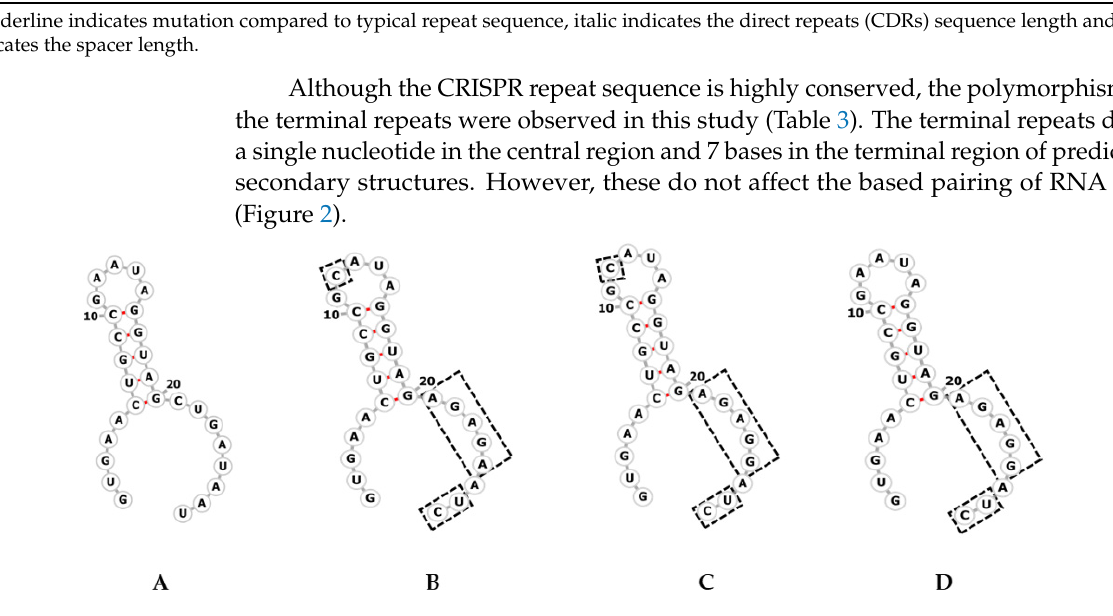
Figure 2. The secondary structures of four CRISPR repeats found in V. parahaemolyticus isolates. Predicted secondary structures were obtained using RNA fold. The dashed boxes indicate the sequence differences between typical repeat ( A ), and terminal repeat of tdh + trh − ( B ), tdh+ trh + and tdh + trh − ( C ), and tdh − trh − ( D ) V. parahaemolyticus isolates, respectively.